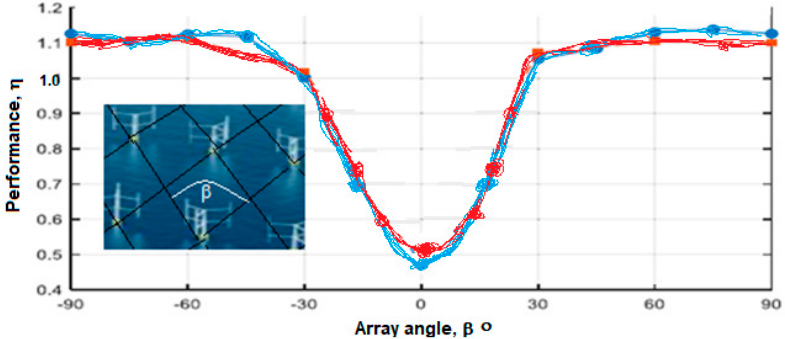
Figure 13. Average performance of two turbines in a pair against array angle β .